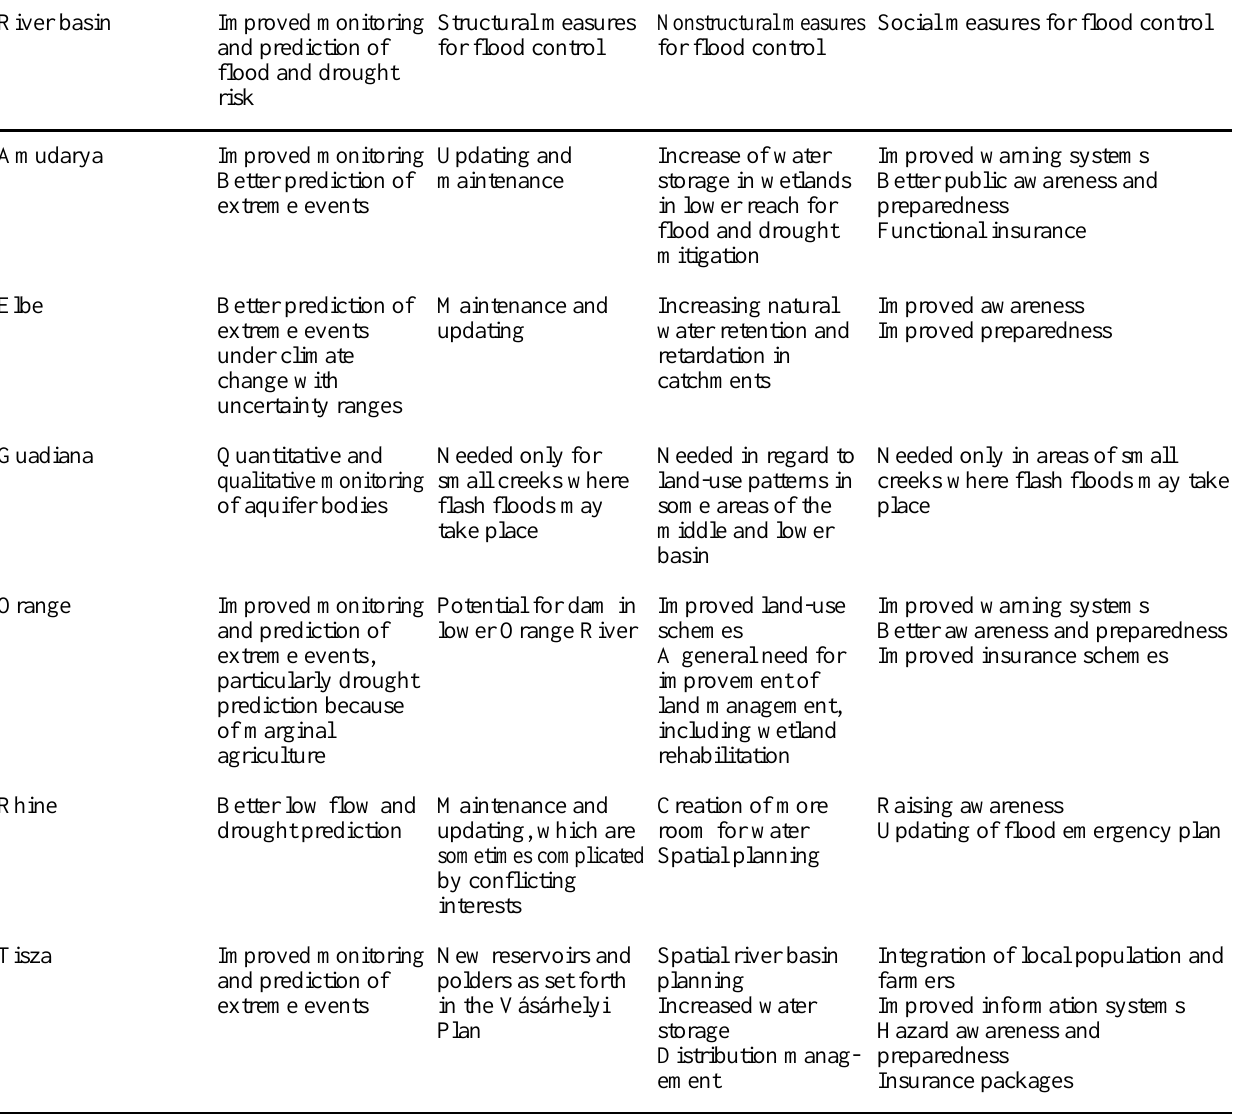
Table 7. Need for improved monitoring and prediction and improvement of measures for coping with floods and droughts in six of the seven basins studied. The Nile, which runs through 10 countries, was not included because of insufficient data. Table 7A. Improved monitoring and prediction and improvement of measures for coping with floods needed. River